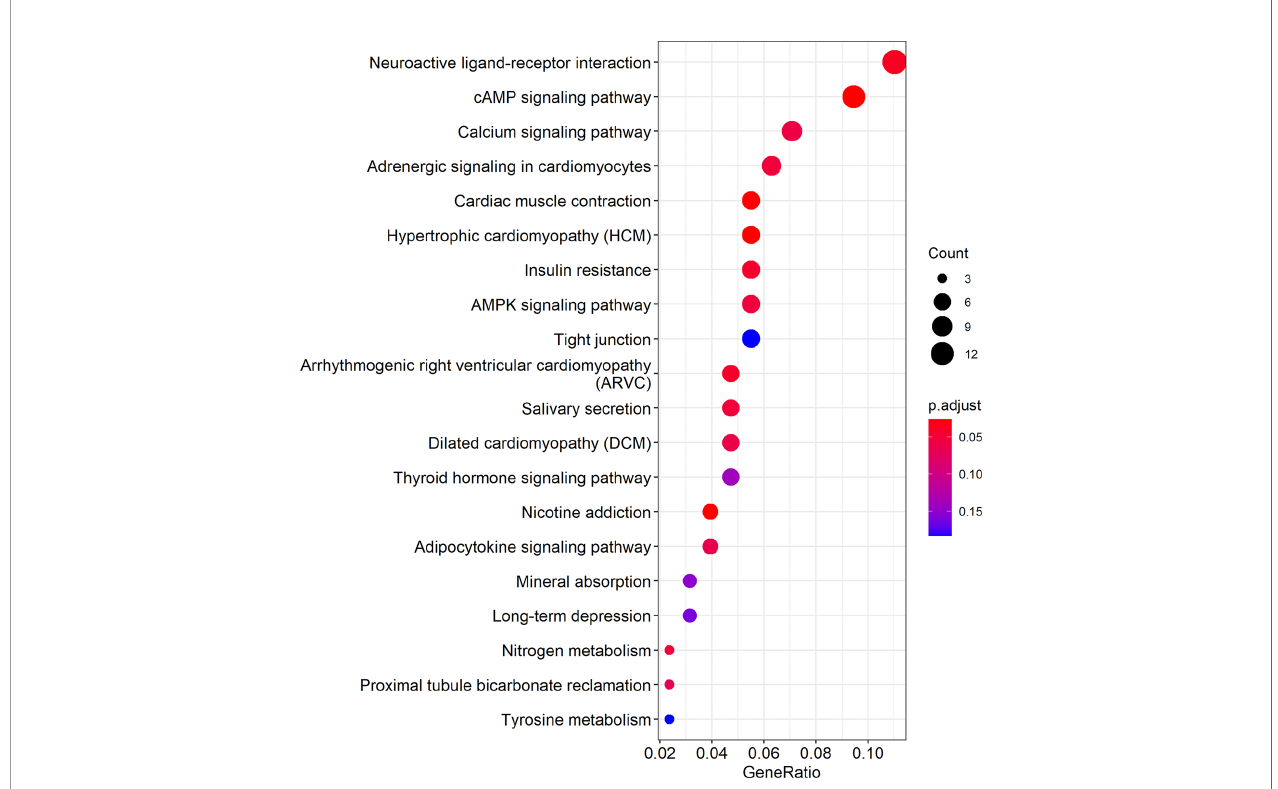
FIGURE 8 | KEGG pathway analysis showed the top 20 biological pathways. In the fi gure, the size of the dots indicates gene count, and the color of the dots indicates the p-value. The abscissa Generatio indicates the ratio of the number of genes mapped to a KEGG pathway to the total number of genes in the